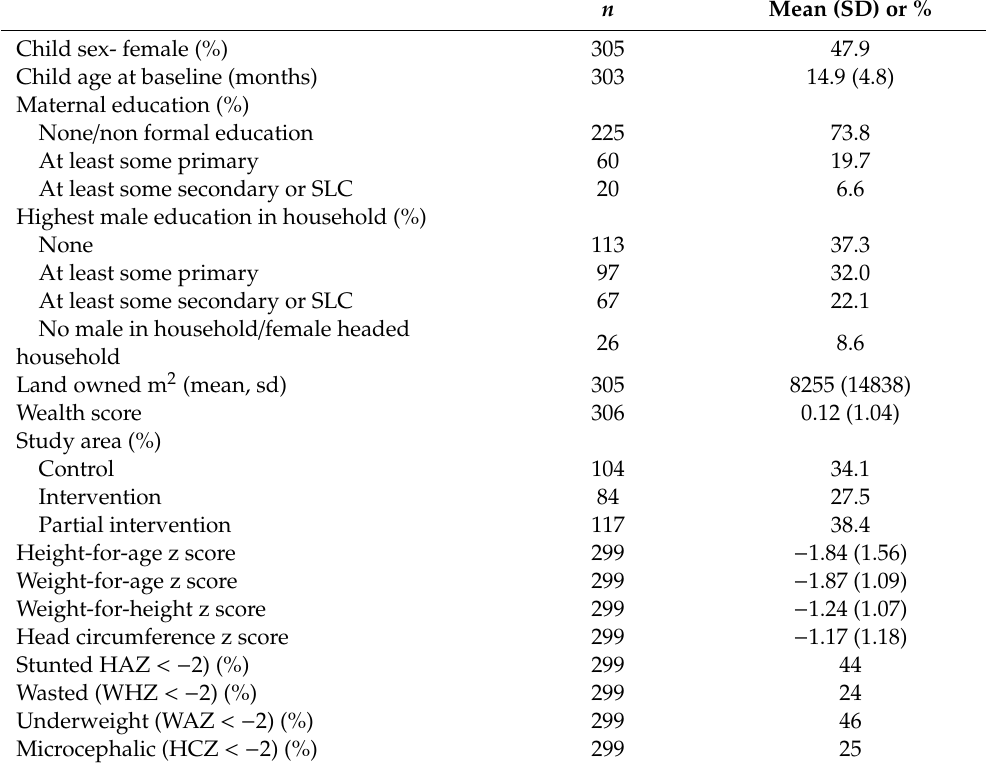
Table 1. Demographic and socioeconomic characteristics of study participants at